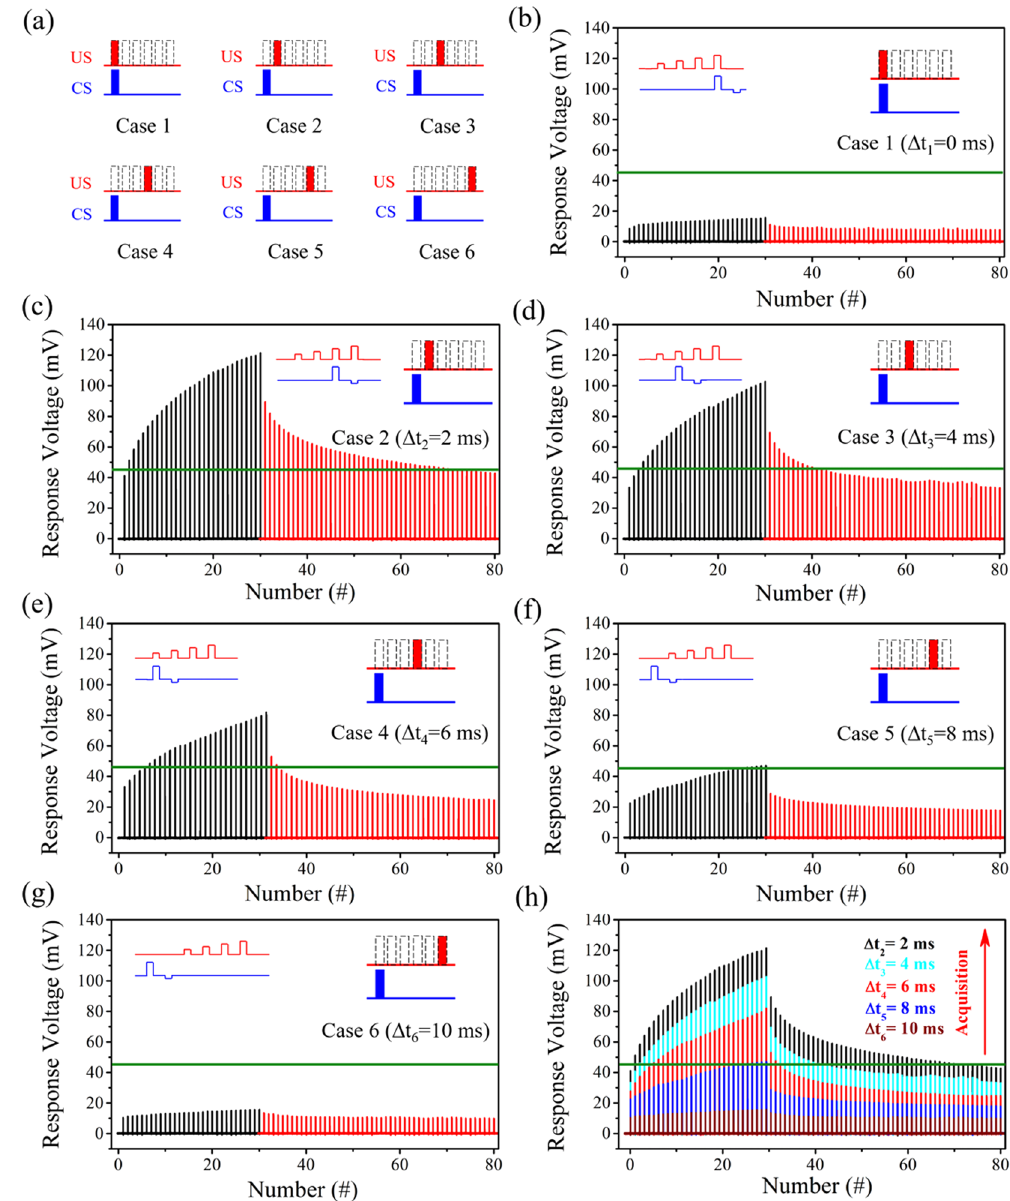
Figure 3. Experimental implementation of acquisition and extinction for the Pavlovian conditioning at different CS-US temporal relations. ( a ) Different cases of CS-US temporal relations. ( b–g ) Corresponding results of the Pavlovian conditioning experiments in different cases as indicated in the insets. The left inset is the applied training pulse pair, and the right inset shows the corresponding CS-US temporal relation. The black lines correspond to the acquisition and the red ones to the extinction. The number of training trials is 30, and the number of extinction trials is 50. The green line at 45 mV is the reference, above which the acquisition succeeds. ( h ) Comparison of all experimental cases in ( c–g